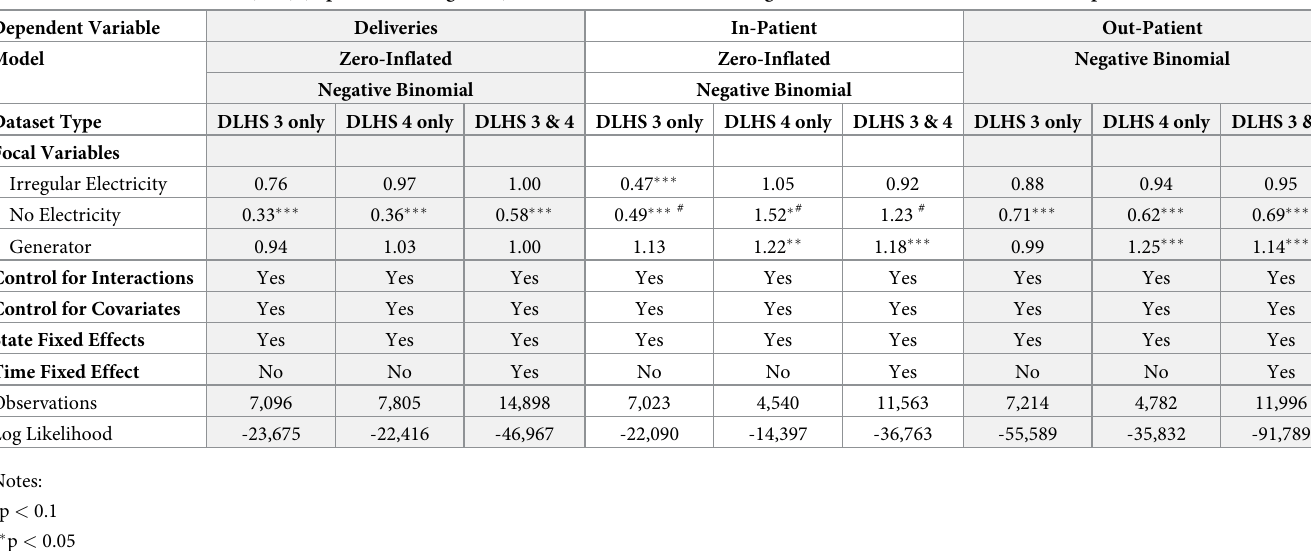
Table 7. Incidence Rate Ratios (IRR) (exponentiated log-odds) for the focal variables in the regression models with different dataset